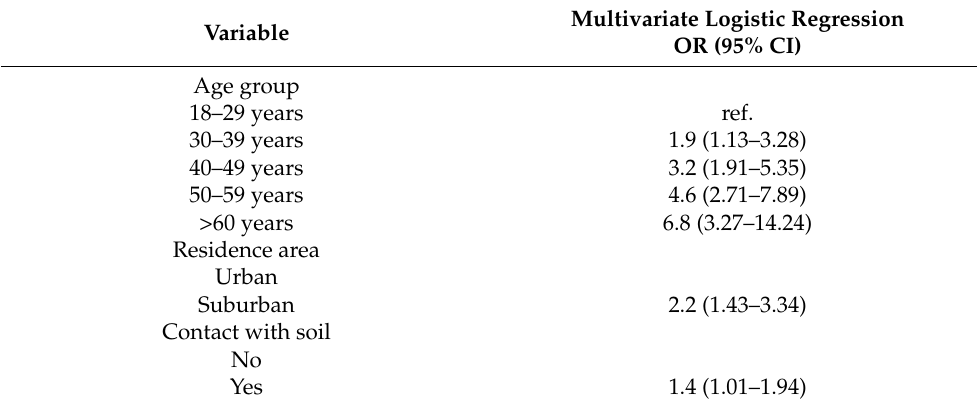
Table 3. Risk factors for T. gondii infection (multivariate logistic regression